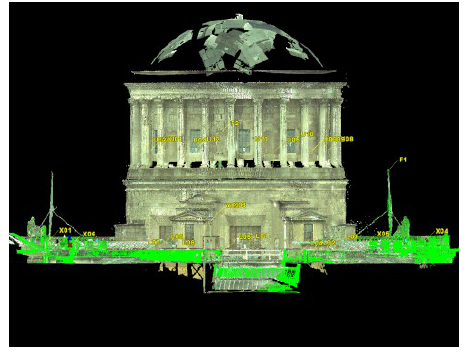
Figure 14: Conservation Documentation Dublin Four Courts based on HBIM and Laser Scanning 5. HBIM – DISSEMINATION – OPEN HBIM